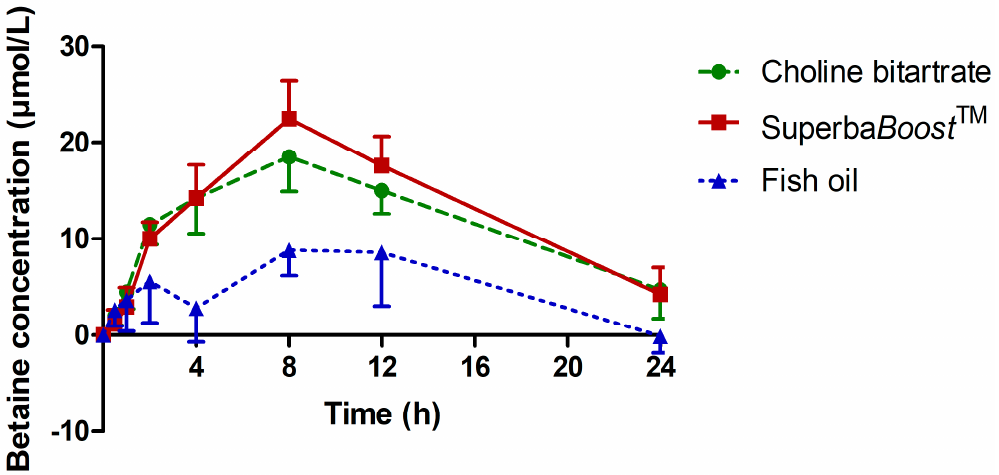
Figure 3. Plasma concentration–time curve of betaine. Values are baseline-corrected. Choline bitartrate: n = 12; Superba Boost TM : n = 12; fish oil: n =